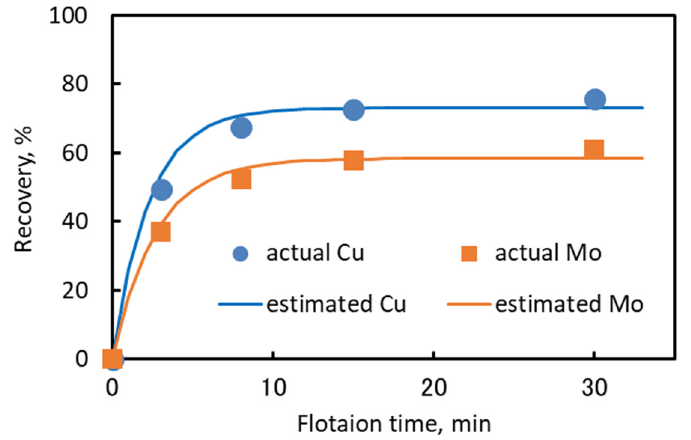
Figure 6. Comparison of actual and estimated flotation recovery of sample F for copper and molybdenum.